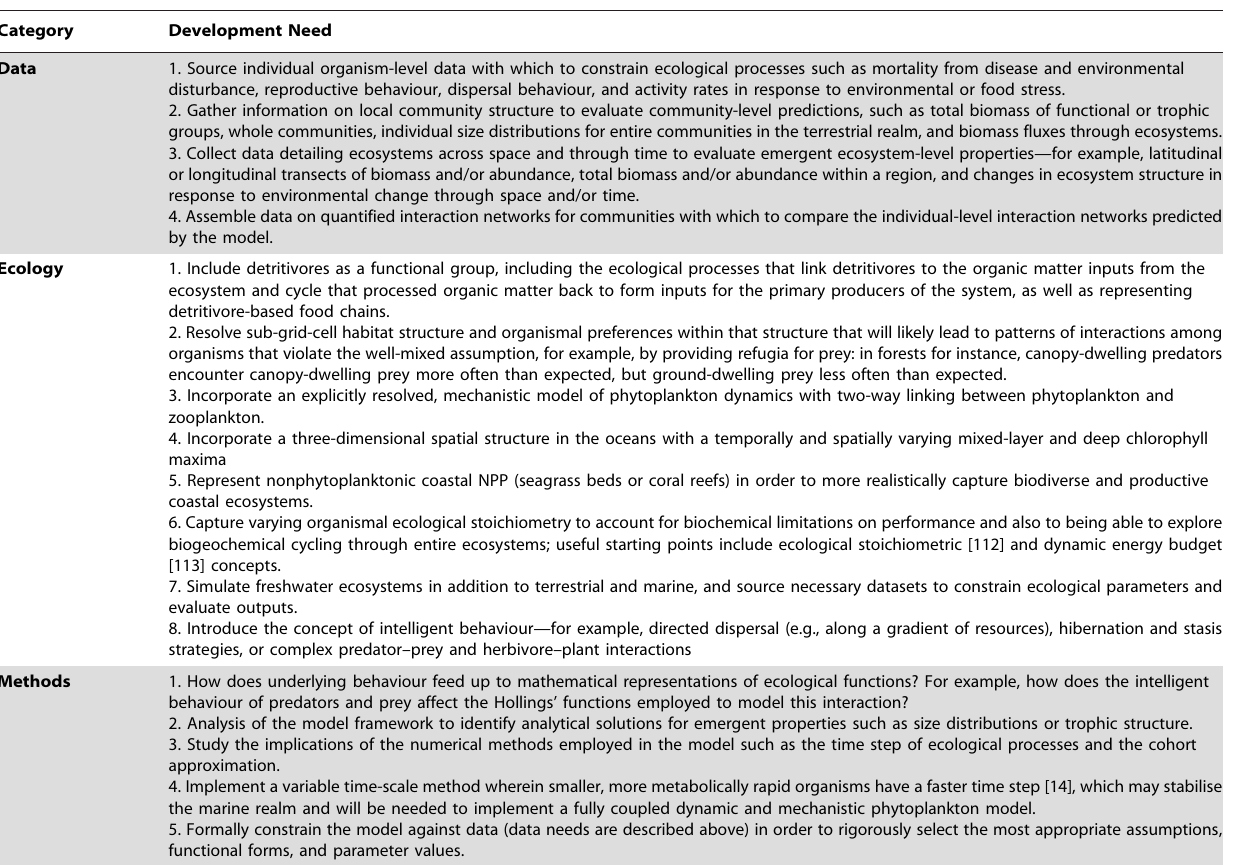
Table 7. The major development needs for the Madingley Model organised by development